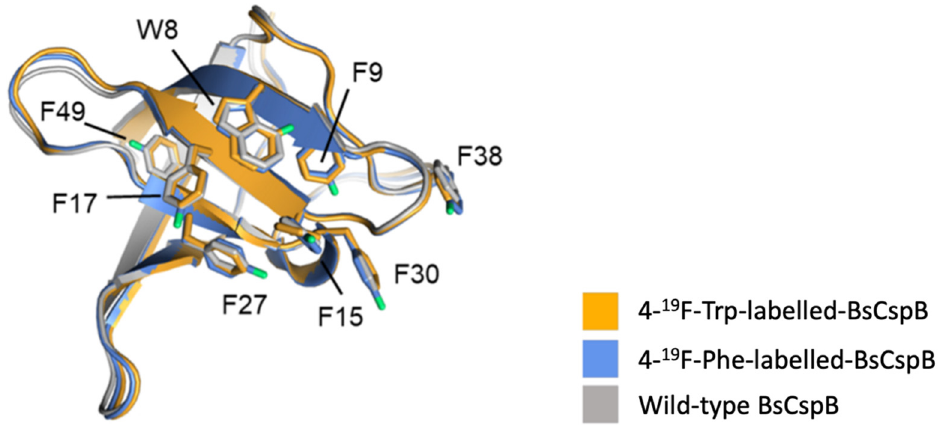
Figure 10. The crystal structures of 4- 19 F-Trp-labelled-BsCspB (orange) and 4- 19 F-Phe-labelled- BsCspB (blue) are shown superimposed onto wild type BsCspB (PDB code 1NMG, grey). The side chains of F-derivatized residues in this study are displayed and labelled according to their sequence numbering. Reprinted with permission from [59].